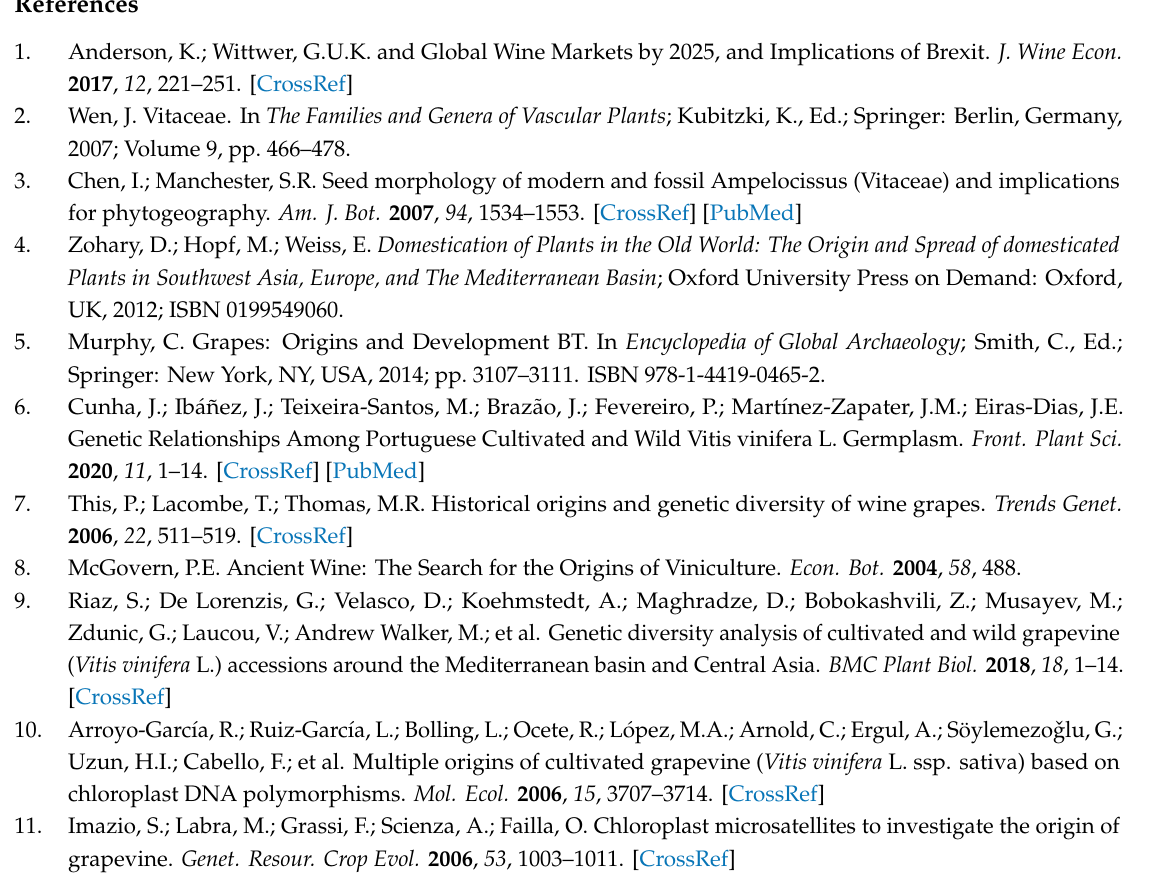
the e ffi ciency of SSRs in delineating the Cypriot Vitis spp. Genotypes. Figure S2: Genetic variability estimates from clone corrected genotypes. Figure S3: Phylogenetic tree of Cypriot grapevine genotypes. Table S1: Sampling locations and germplasm information across collection sites within the Commandaria zone. Table S2: Primers and panels used for the amplification of alleles across 11 loci. Table S3: Alleles size and MLGs across the 164 Cypriot genotypes sampled and analyzed. Table S4: Frequency of alleles detected for every locus in the Cypriot grapevine collection. Table S5: Ancestry probability of STRUCTURE analysis across the 164 Cypriot